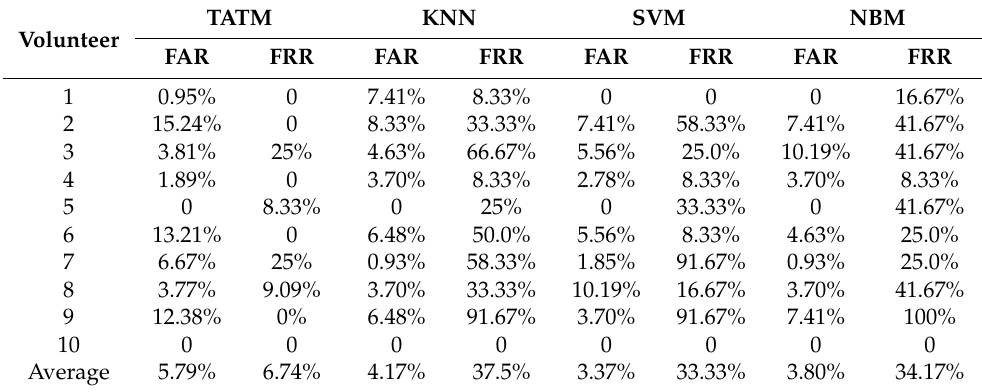
Table 4. FAR and FRR of different algorithms.